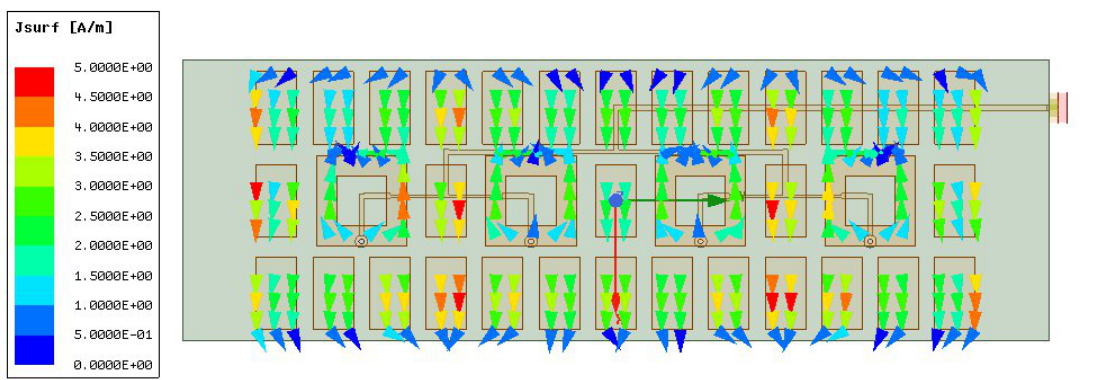
Figure 3. Surface current distribution at 4.5 GHz for the 2 × 2 metasurface array.